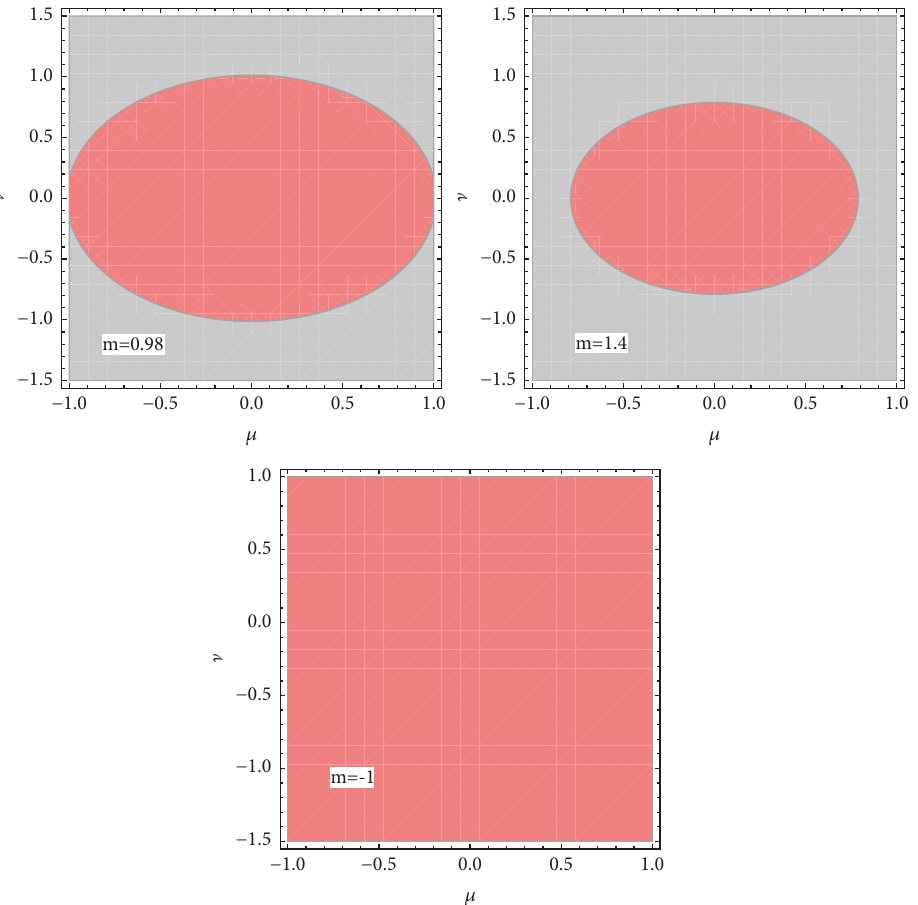
Figure 5: Plots for power-law scale factor coupled with phantom fluid. Blue and gray zones represent contraction and accelerated expansion of cosmos,